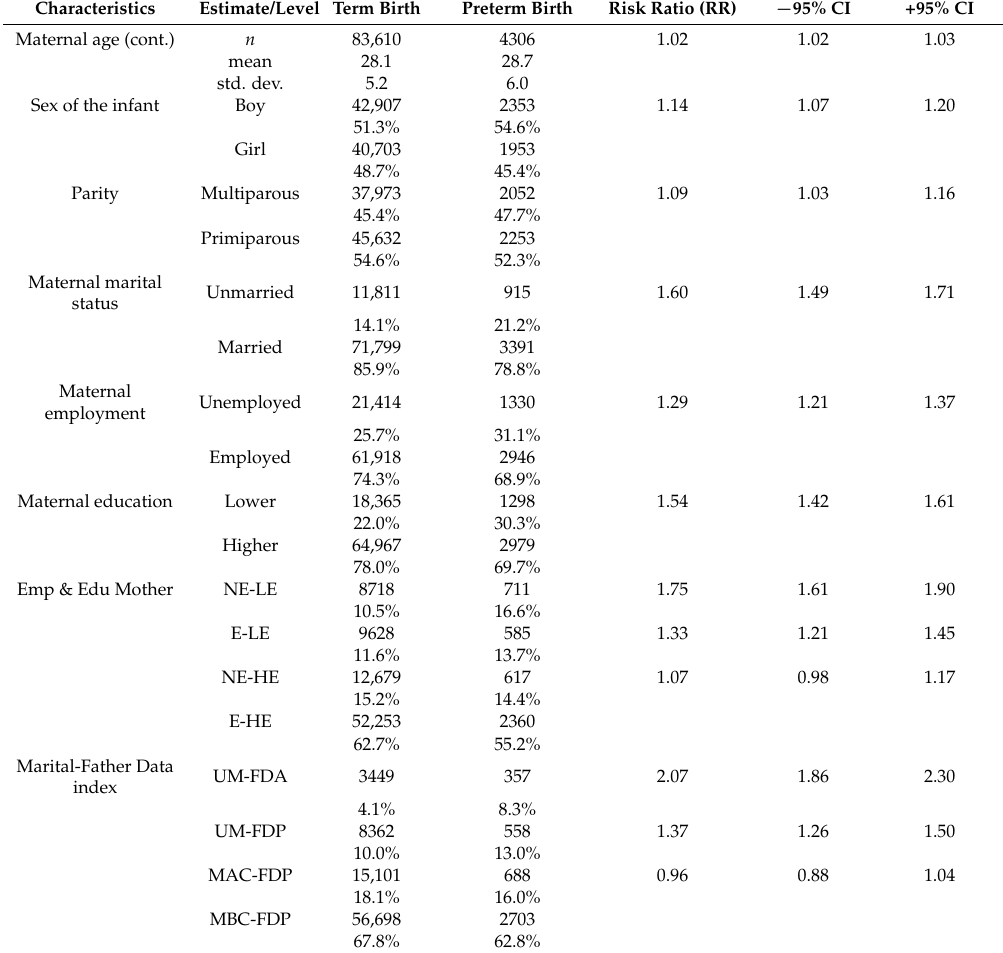
Table 1. Characteristics associated with preterm birth (PTB) among singleton, live births. Characteristics Estimate/Level Term Birth Preterm Birth Risk Ratio (RR) − 95% CI +95% CI Maternal age (cont.)